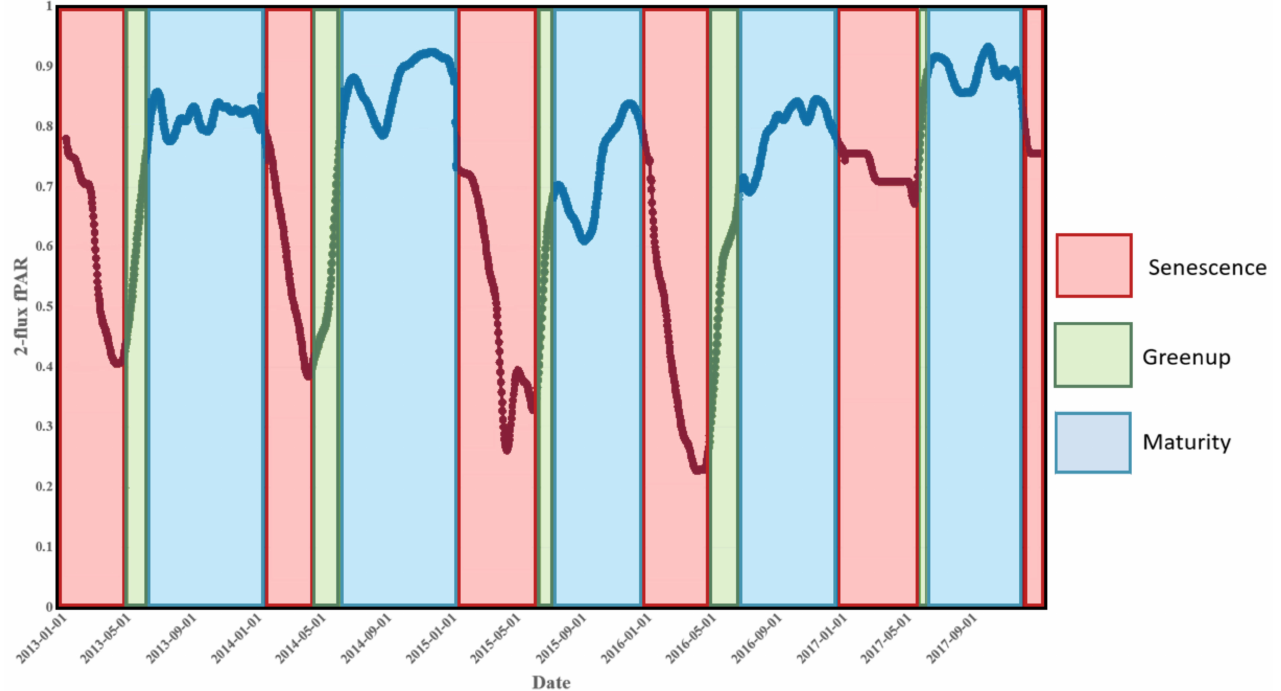
Figure 3. Breakdown of the 2-flux fPAR time-series into phenophases. Phenophases were determined using the R package “Phenex”(phenex_1.4–5.tar.gz) and based on the local thresholds determined per